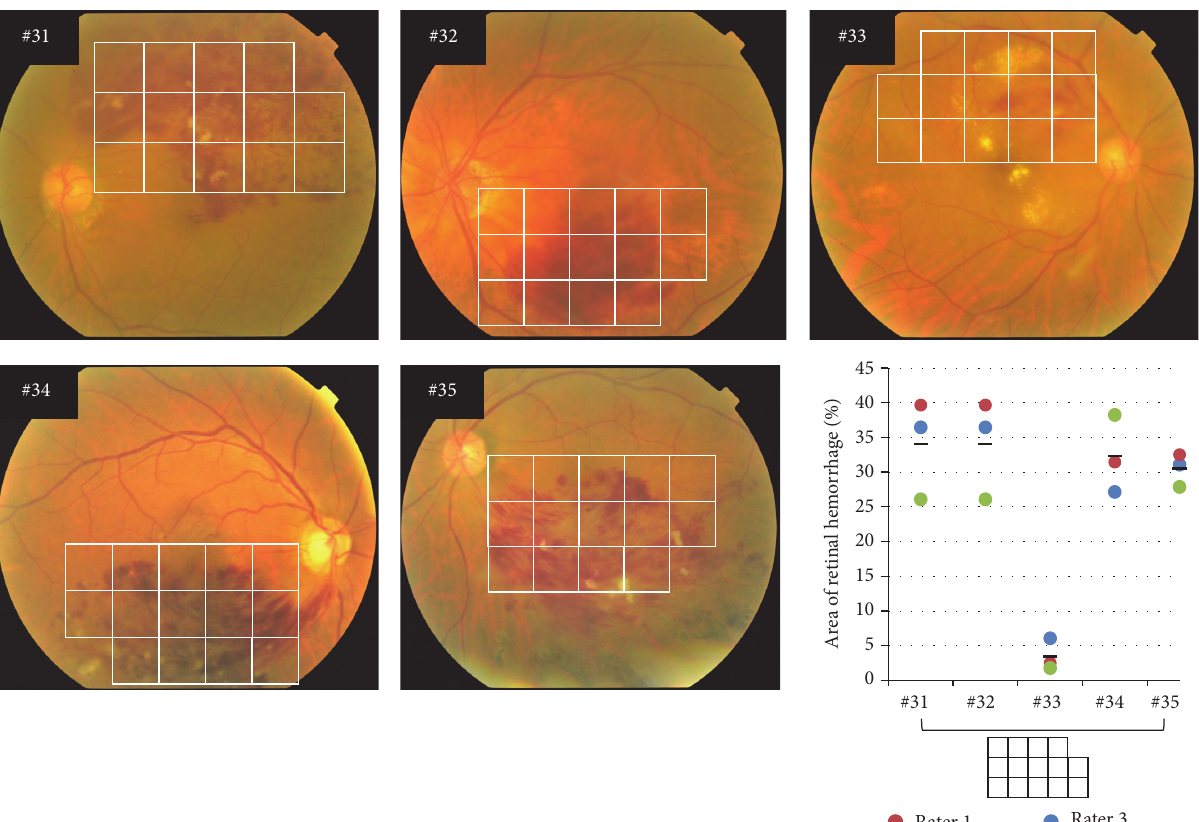
Figure 3: Five fundus photographs with poor quality, and the results of retinal hemorrhage sizes measured by using grid with 14 squares. The grid with 14 squares was laid over five fundus photographs of poor quality (#31–#35). The most right panel at the bottom is a graph plotting the retinal hemorrhage size measured using the grid with 14 squares by the three raters and averaged values.